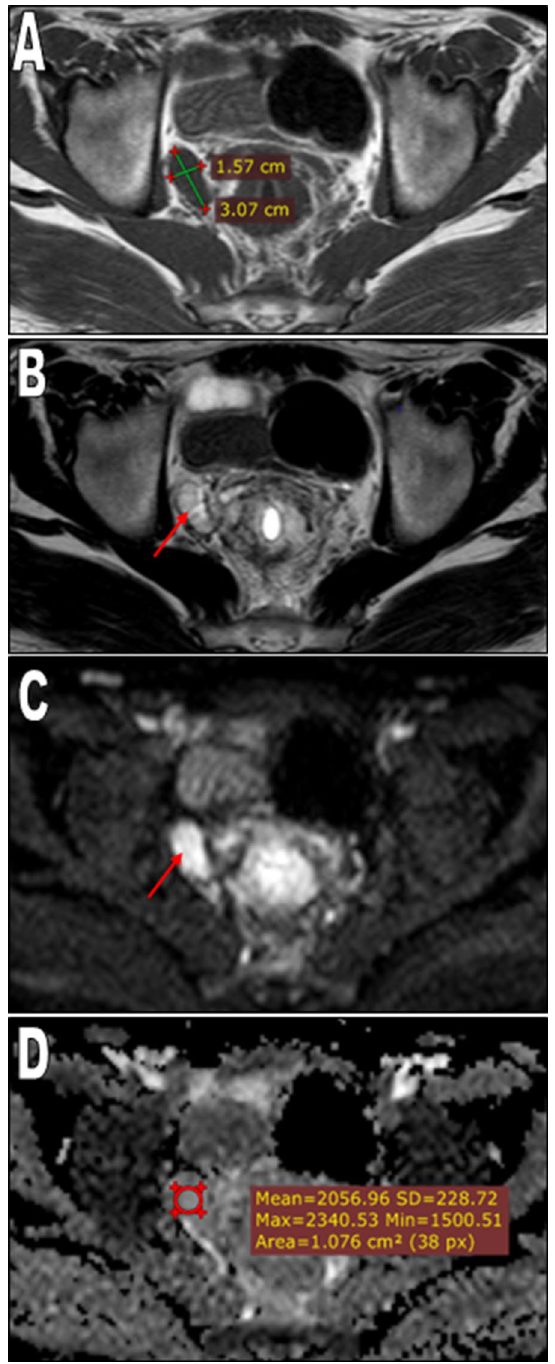
Fig. 4 MRI for a 25-year-old male patient with pathologically proven rectal mucinous carcinoma presented clinically with bleeding per rectum . A Axial T1 WI and B Axial T2 WI showed enlarged right peri-rectal lymph node, measuring about 30 16 mm at maximum × axial dimensions, eliciting low T1 and heterogeneous high T2 signals, has an oval configuration with regular borders, morphologically it is considered to be suspicious lymph node. C DWI and D ADC map showed no restricted diffusion; with the predominant bright areas on DWI corresponding to high signal areas on the ADC map. ADC mean 2 10 –3 mm 2 /s. Histopathological analysis confirmed = × metastatic nature of the examined lymph